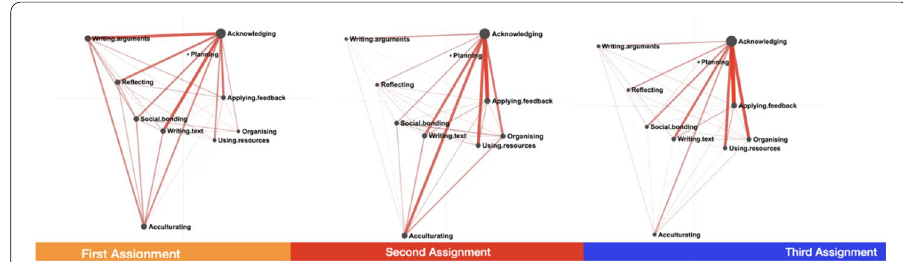
Fig. 6 Epistemic network graphs of the central SRL tactics per assignment phase